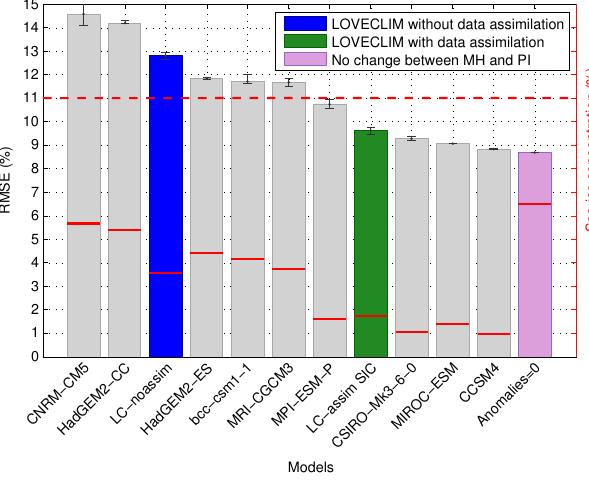
Figure 6. Ranked RMSE between the MH sea ice anomalies (ref- erence period AD1850–1900) simulated by each model and the proxy-based reconstructions. The error bars correspond to the range of the RMSE when changing the reference period to AD1850–1875 and AD1875–1900. The purple bar is the RMSE computed assum- ing no change between the MH and the PI and is thus a measure of the mean signal of the data. The dashed red line is the estimate of the mean data error (to be read with the right axis). The red lines are the mean signals of the models and the data (purple bar), both esti- mated as the mean of the absolute value of the difference between the MH and the PI period (to be read with the right